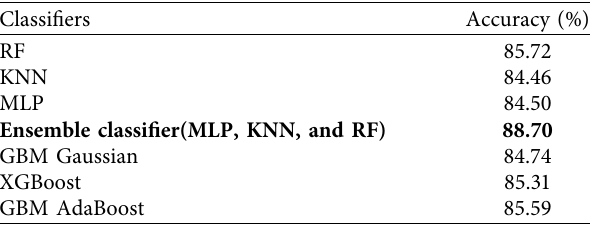
Maximum accuracy achieved is highlighted in bold. Table 7: Classification results using top 10 features selected by Univariate.